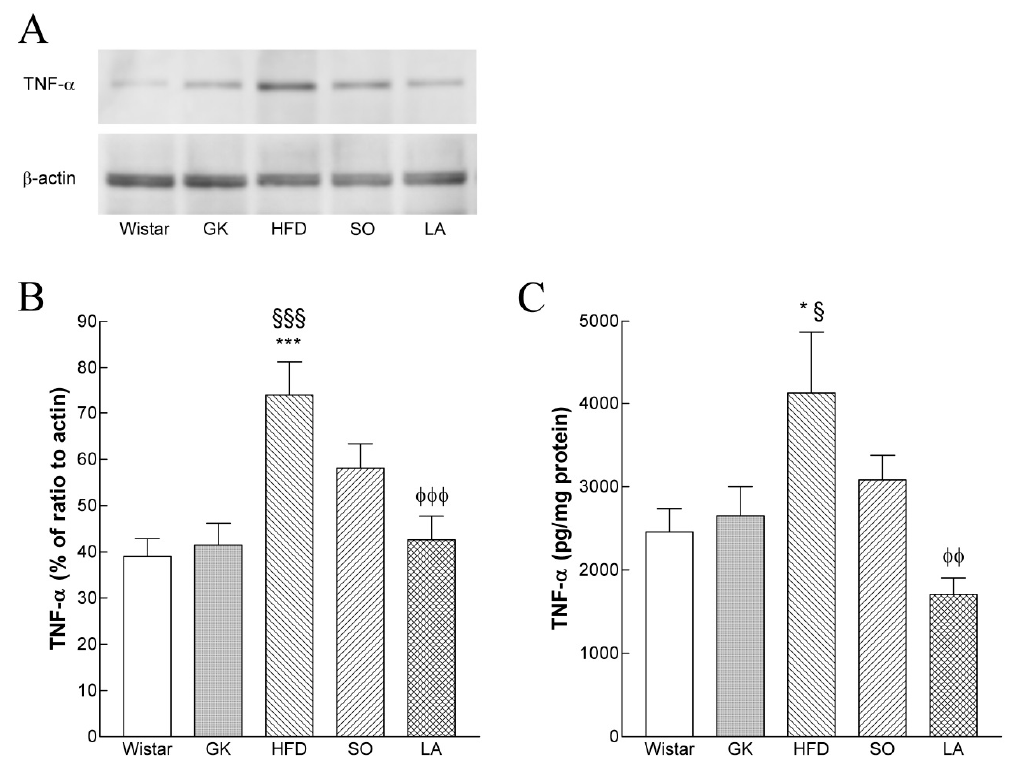
Figure 4. Effects of α -lipoic acid ( α -LA) on tumor necrosis factor- α (TNF- α ) levels in the liver of Goto-kakizaki (GK) rats fed a high fat diet (HFD) compared with nondiabetic Wistar rats. ( A ) representative Western blot analysis of TNF- α levels. ( B ) Average densitometry data (normalized with β -actin values) expressed as a percentage. ( C ) Protein TNF- α levels in livers of Wistar, Goto-kakizaki (GK) rats control and GK fed a high fat diet (HFD) with or without vehicle (soybean oil, SO) or α -LA. Data are expressed as mean ± SEM (n = 7 animals per group). * p < 0.05, *** p < 0.001 vs. Wistar group, § p < 0.05, §§§ p < 0.001 vs. GK group, φφ p < 0.01, φφφ p < 0.001 vs. GKHFD group.